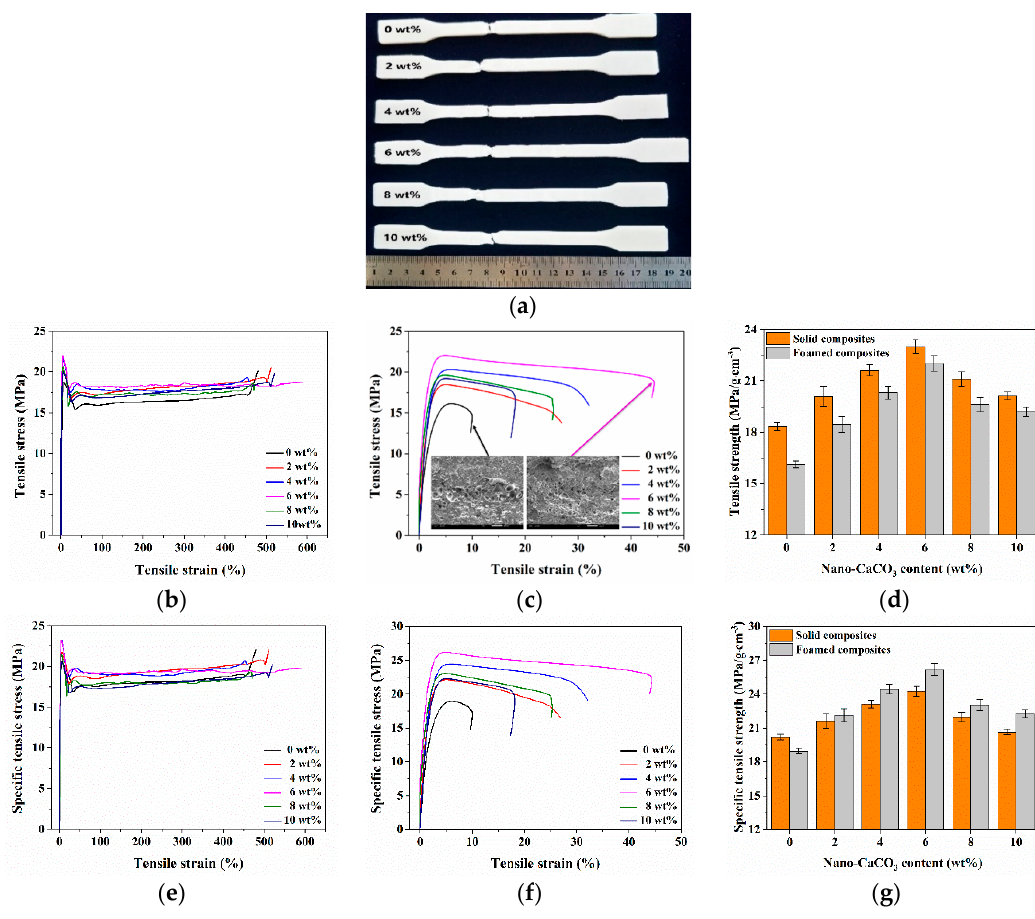
Figure 6. Tensile results of solid and foamed composites: ( a ) foamed samples after tensile tests; ( b , c ) tensile stress strain curves of solid and foamed composites, respectively; ( d ) the tensile strength; ( e , f ) specific tensile stress strain curves of solid and foamed composites, respectively; ( g ) the specific tensile strength.